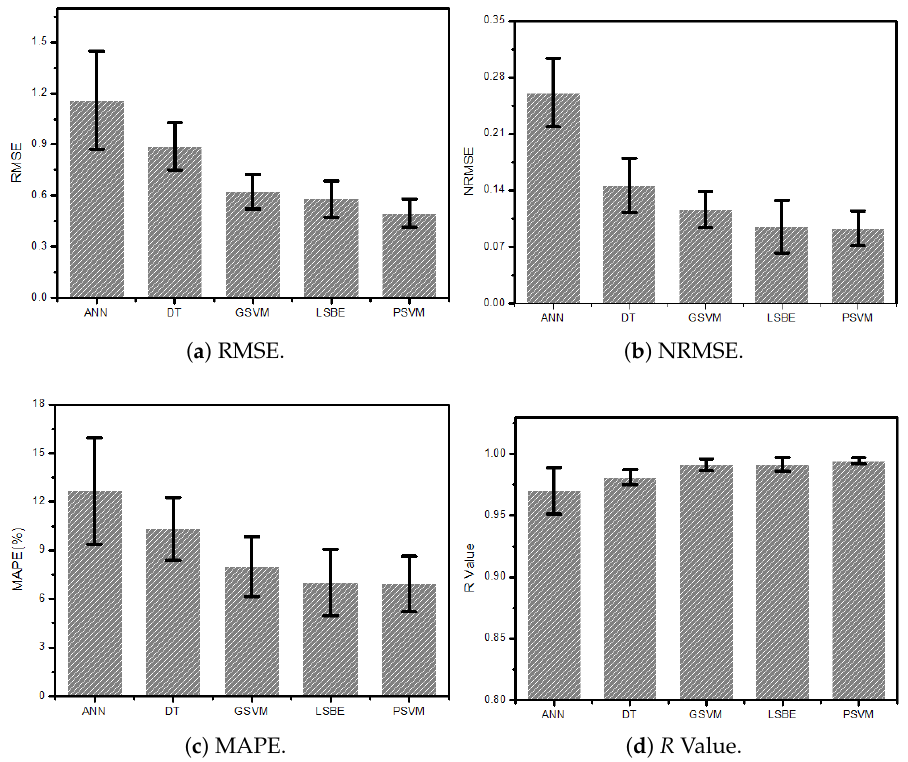
Figure 8. Comparison of different machine learning algorithms for inception voltage: ( a ) RMSE, ( b ) NRMSE, ( c ) MAPE, ( d ) R